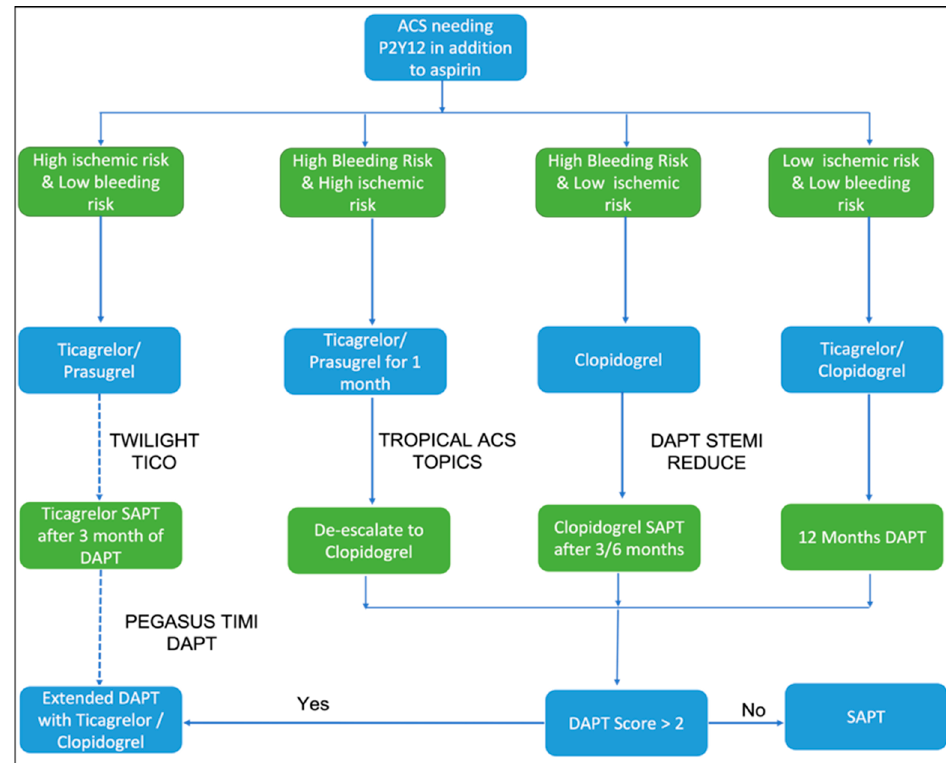
Figure 5. Navigating the maze of dual antiplatelet therapy after ACS based on contemporary clinical trial evidence. The DAPT score represents a combination of various demographic, clinical, and angiographic features for guiding the decision to extend DAPT beyond a year after ACS.